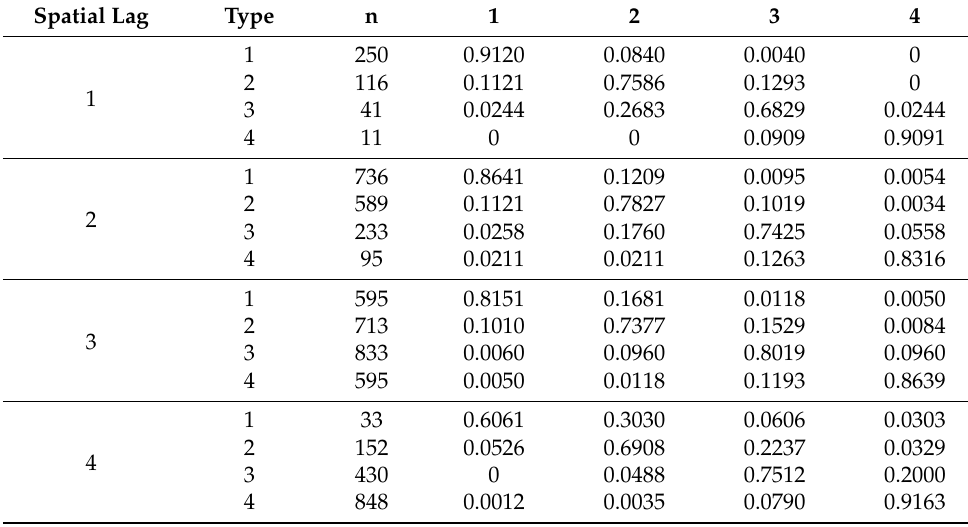
Table 5. Spatial Chain Transition Probability Matrix for